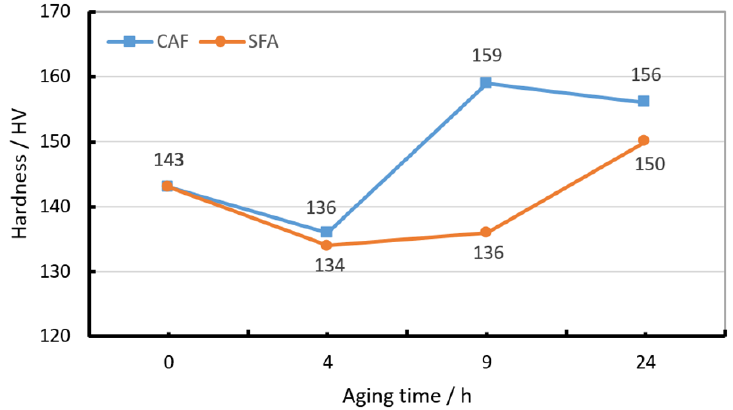
Figure 7. Hardness of AA2524 under creep age forming and artificial aging.